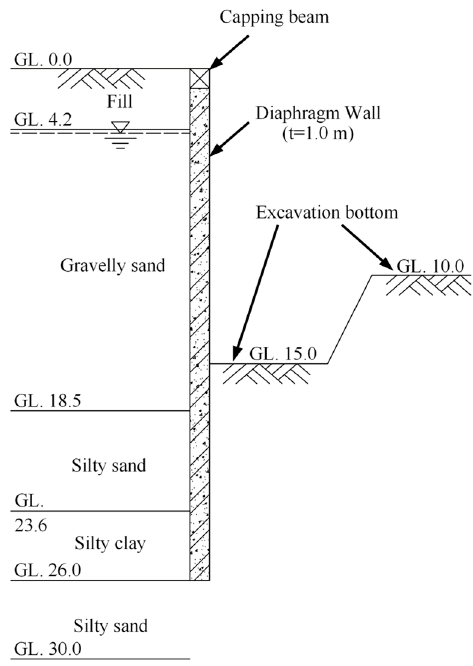
Figure 3. Cross-section and geological profile of the excavation at the pumping station. It should be noted that the use of struts is not considered in this paper and so they are not shown here for the sake of simplicity. (Units: m.).